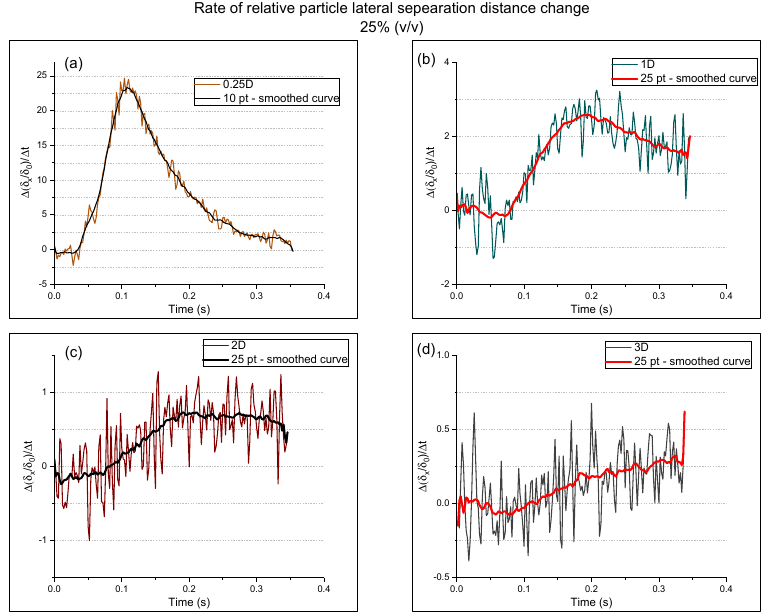
Figure 8. Plots representing the rate of normalized relative particle lateral separation distance as a function of time for prominent repulsion regime 25% ( v/v ) at various initial separation distances. ( δ ) : ( a ) 3D, ( b ) 2D, ( c ) 1D, and ( d ) 0.25D. The plots indicate an inverse relationship between the rate of normalized relative particle lateral separation distance and lateral separation distance. A velocity analysis was performed to further quantify the particles’ repulsive behav- ior as a function of the associated 𝑅𝑒 (cid:3043) . Figures 9 and 10 show the vertical and lateral ve- locity components of the extreme cases 0.25D–25% and 0.25D–100%, respectively. Inspect- ing Figure 9, the settling velocity was determined based on the histogram analysis, where a Lorentz fit was utilized to construct the probability density function (PDF) for both ve- locity components. The instantaneous vertical velocity data points were fitted using an exponential decay function. Even though the sampled data have shown a range of velocity fluctuations, the function fit demonstrated a high prediction accuracy (R 2 = 0.95) in cap- turing the acceleration regime and the terminal velocity for a range of 300 milliseconds.